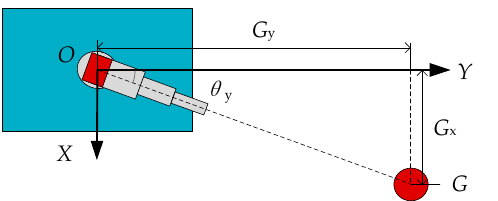
Figure 3. The coordinate relationship between the water jet and the desired target G .